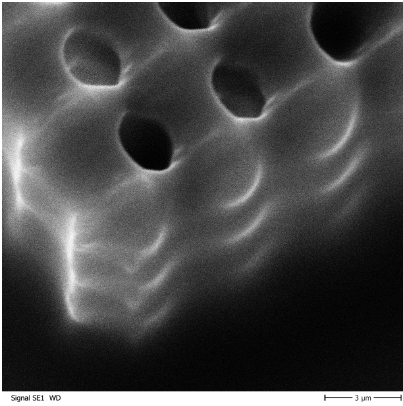
Figure 20. Dimension scale: hex structure (7.5 mi- crons x 8.66 microns side length per element)